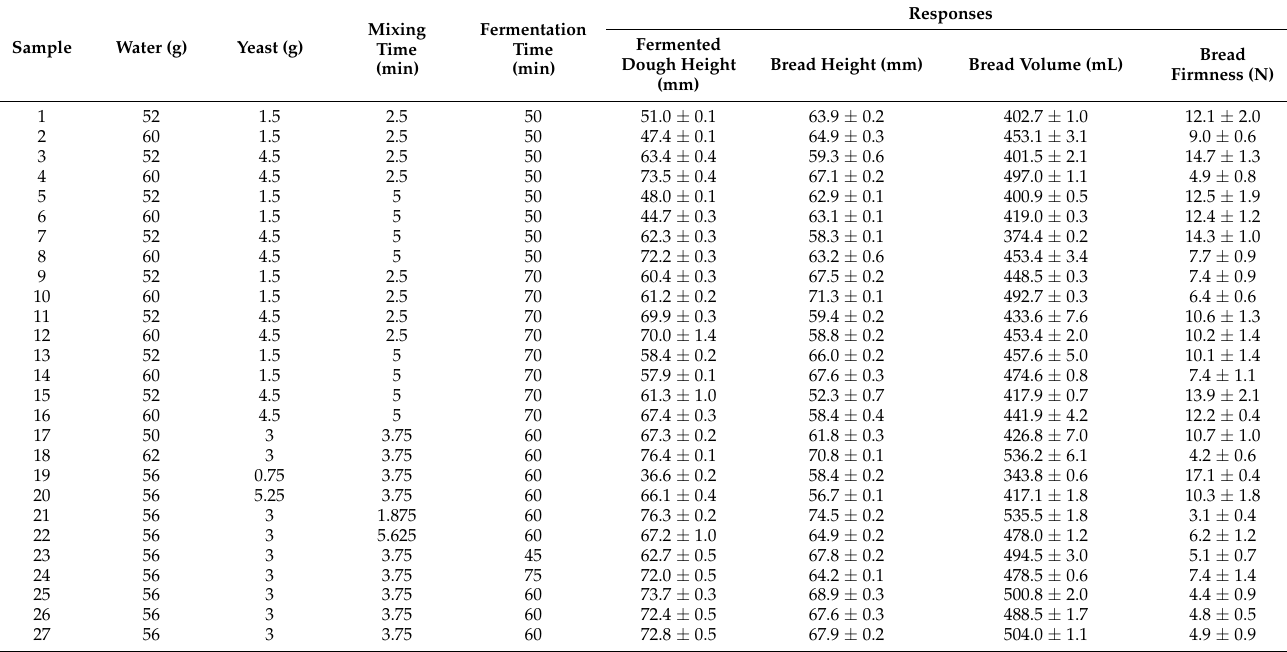
Table 4. Fermented dough height and height, volume, and firmness of bread prepared with ‘O-free’ flour.